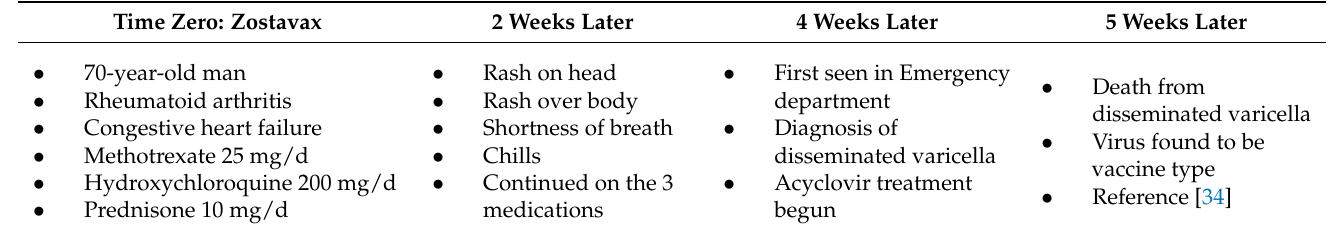
Table 4. Fatal SAE after live zoster